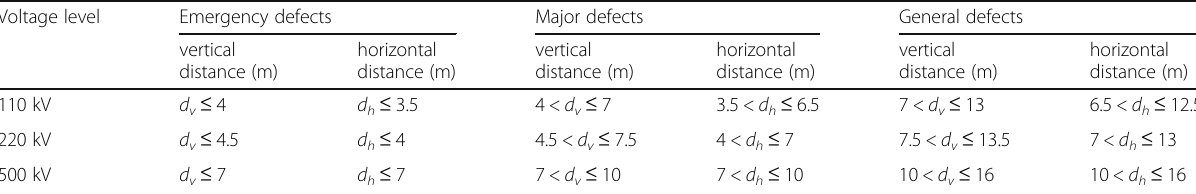
Table 3 Defect classification of tree barrier [29] Voltage level